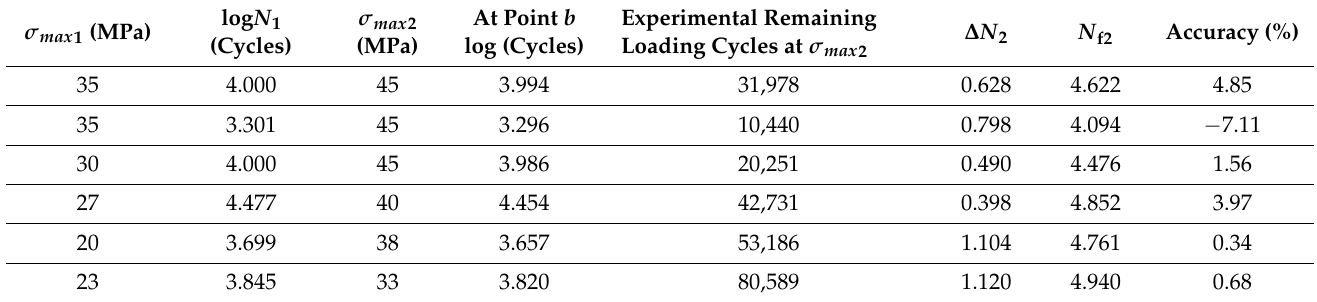
Table 2. Low–high fatigue loading for the remaining fatigue